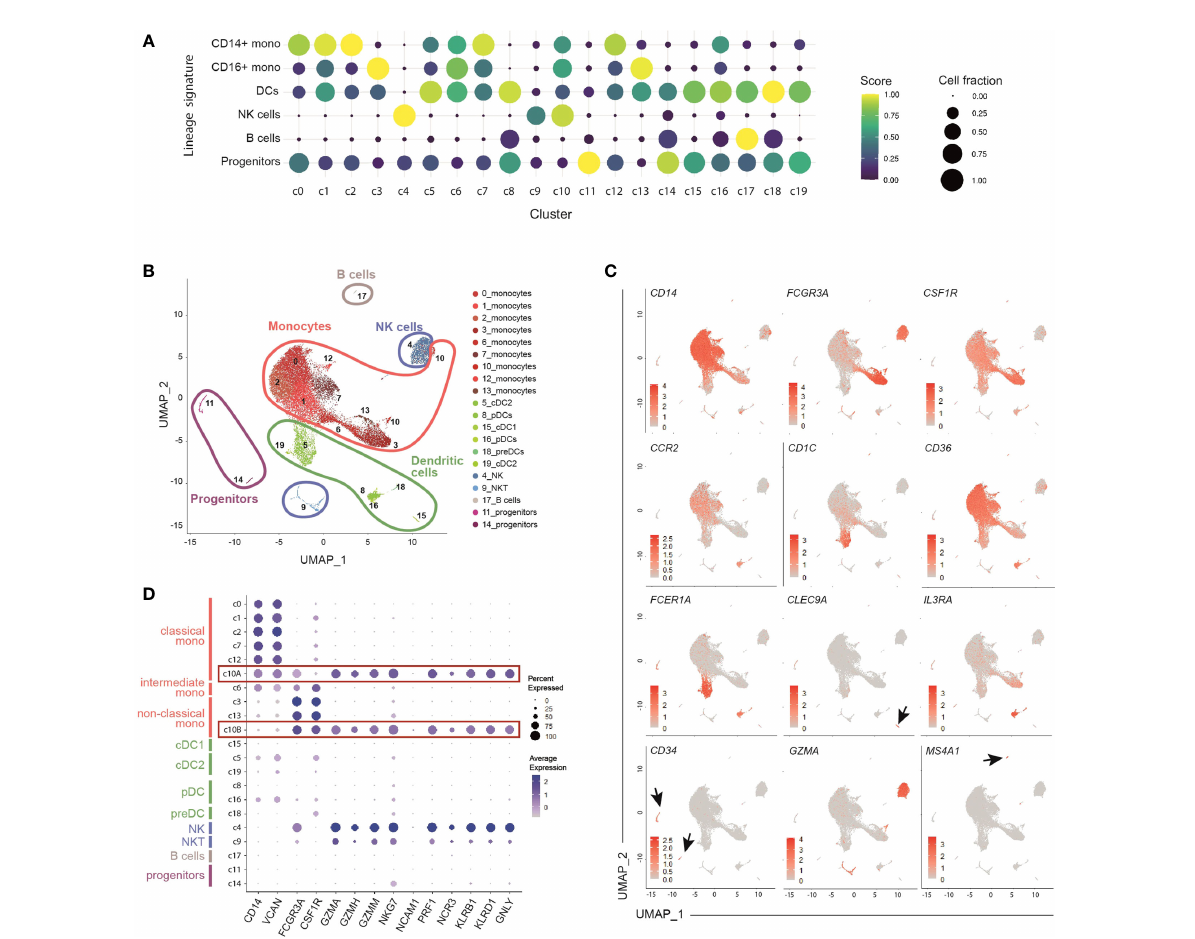
FIGURE 1 Identi fi cation of 9 clusters of circulating monocytes by single-cell RNA sequencing of healthy peripheral blood HLA-DR+ cells. (A) Dot-plot showing annotated immune cells by lineage signatures (genes belonging to each signature are listed in Table S3). ssGSEA score-based signature expression is colored-coded from blue (lower) to yellow (higher); circle size indicates the fraction of cells expressing the signature. CD14 + mono, classical CD14 + monocytes; CD16 + mono, non-classical CD16 + monocytes; DCs, dendritic cells; NK cells, natural killer cells. (B) UMAP projection of CD45 + Lin - HLA-DR + cells (n = 26,474) showing 20 clusters belonging to 5 major immune cell subsets. Clusters are numbered according to their size, from the largest (cluster 0) to the smallest (cluster 19). Each dot represents an individual cell. (C) Feature plots showing the expression of key genes adopted for manual annotation of myeloid cell clusters. Gene expression is colored-coded from gray (lower) to red (higher). (D) Dot-plot showing the expression of key genes adopted for manual annotation of clusters 10A and 10B. Gene expression is colored coded from gray (lower) to blue (higher); circle size indicates the fraction of cells expressing the